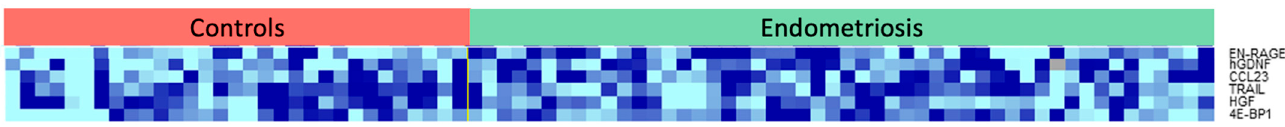
Table legend: Geom.: geometric, EN-RAGE: Receptor for Advanced Glycation End-products binding protein, CCL23: chemokine ligand 23, HGF: Hepatocyte Growth Factor, 4E-BP1: eukaryotic translation initiation factor 4E-binding protein 1, TRAIL: TNF-Related Apoptosis Inducing Ligand, hGDNF: human Glial-derived Neurotrophic factor, IL-18: Interleukin-18, IL-6: Interleukin-6, IL-8: Interleukin-8.